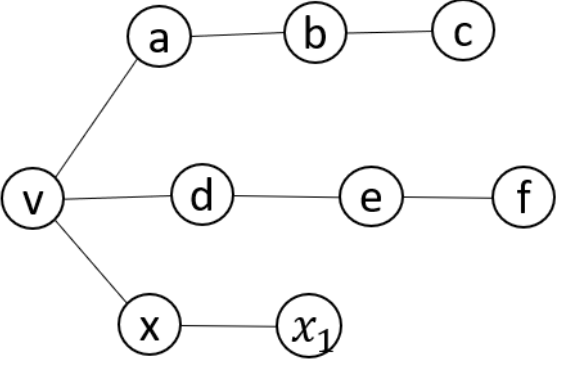
Figure 4. Sample Network with an